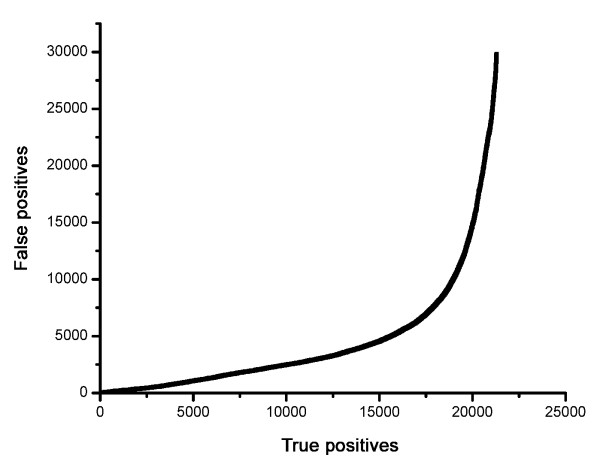
Sensitivity plot for the detection of errors in automatically produced multiple sequence alignments. The set of positional matches in ClustalW alignments was ranked by ascending P-values for corresponding profile positions and classified as true or false predictions. True positive predictions are errors in ClustalW alignments compared to the BaliBase reference. False positive predictions are correst position matches consistent with BaliBase.